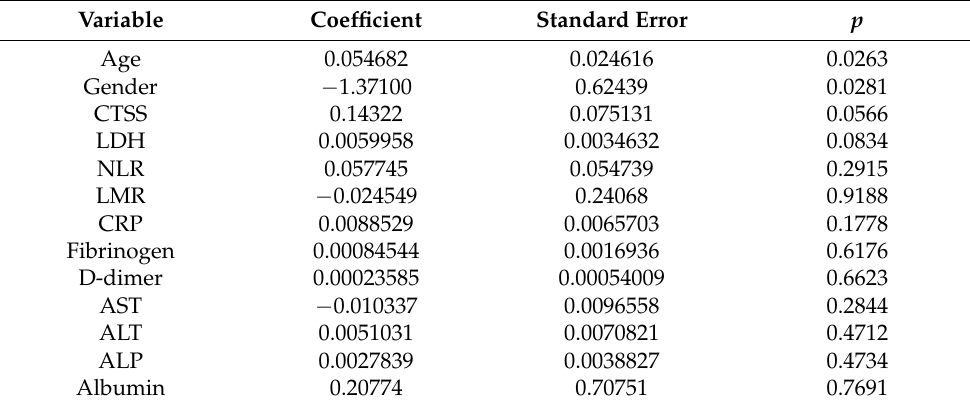
Table 2. Multivariate analysis with logistic regression.